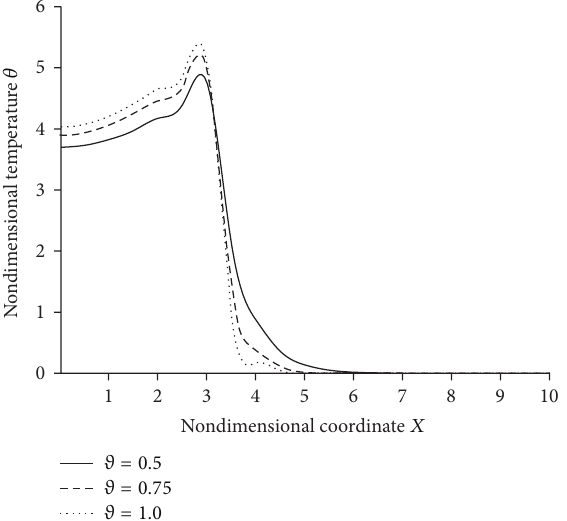
Figure 10: Nondimensional temperature distribution for different 𝜗 values.